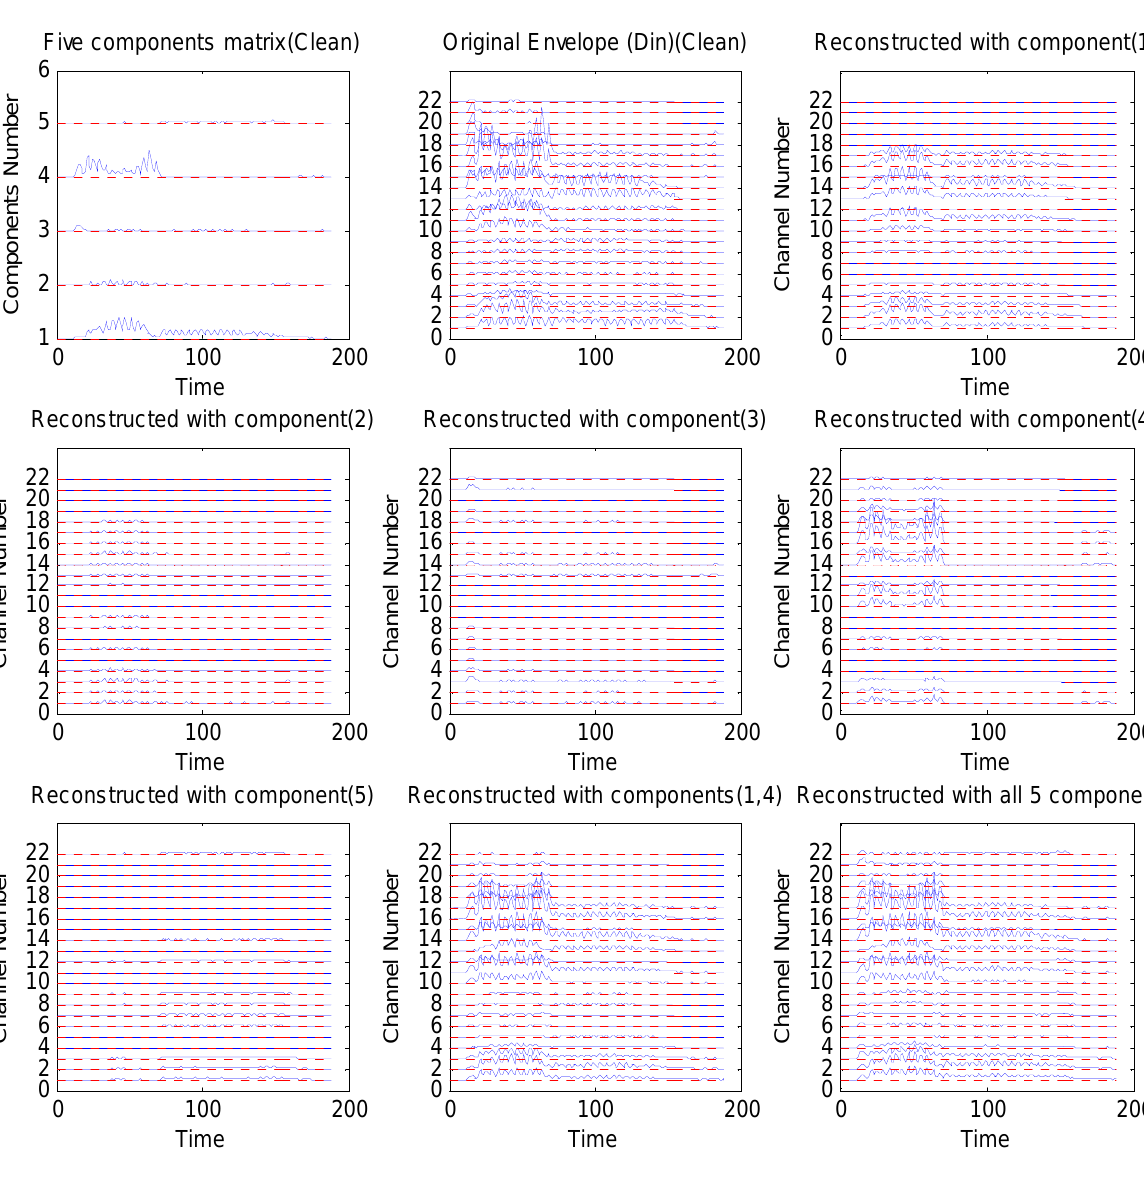
Figure 2. An example of the NMF reconstruction envelopegram with different components of the word ‘Din’ (see [39] for more detail). The top left panel is the component matrix, W , which determines the activation of different basis vectors over time. The top middle panel is the original envelopegram , Z , of the word ‘Din’, and the other panels are the reconstruction results with different